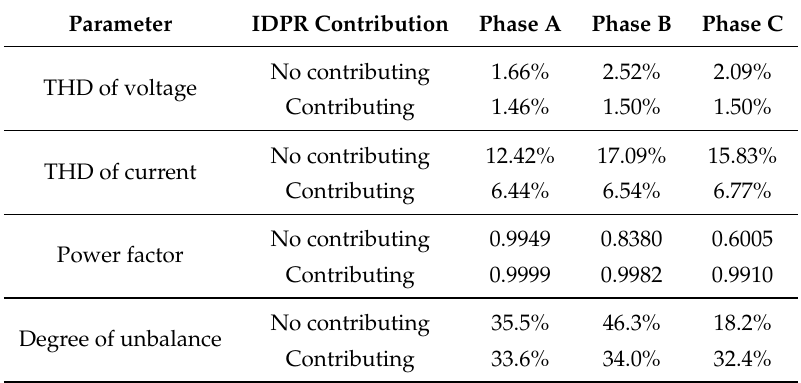
Table 9. Real measurements for proving the IDPR